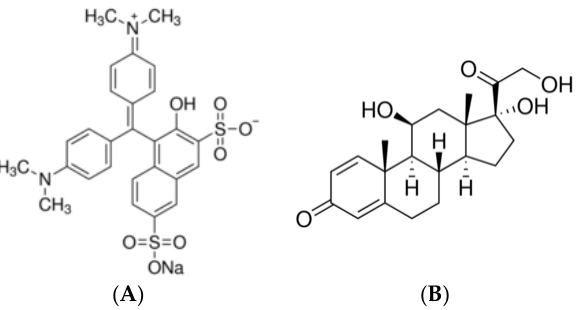
Figure 2. Chemical structure of ( A ) lissamine green and ( B ) prednisolone.